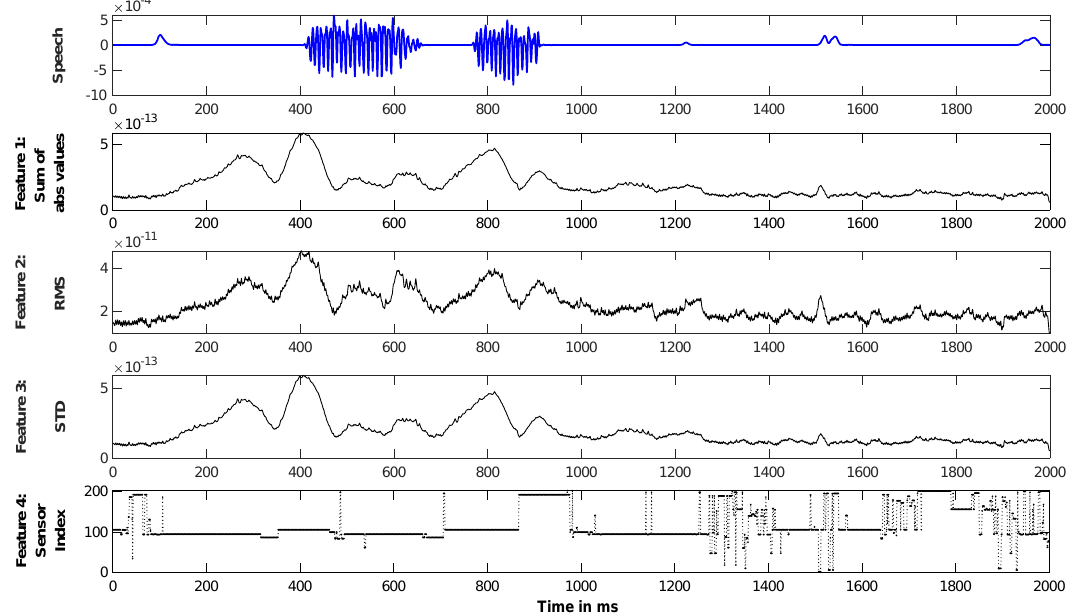
Figure 3. The four features selected for the experiment are shown for one example trial (in black). Corresponding speech signal is shown in blue. Feature 1: sum of absolute (abs) values; Feature 2: root mean square (RMS) values; Feature 3: standard deviation (STD) across sensors; Feature 4: Index of the sensor with highest magnitude at each ms of